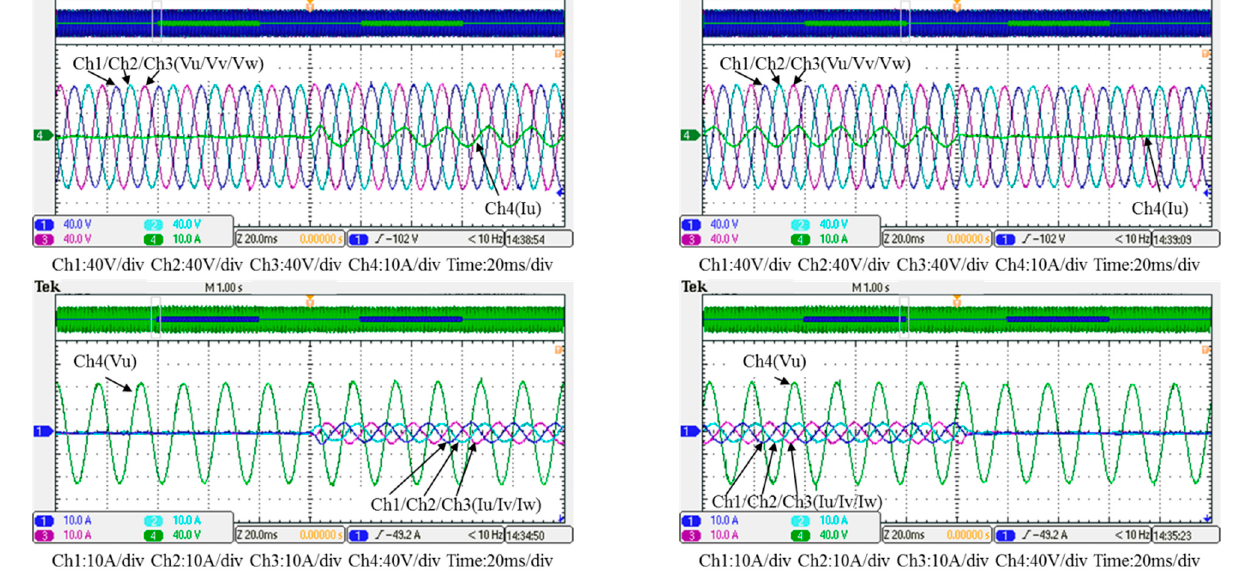
Figure 31. Detailed view of Figure 29: ( a ) near t 1 ; ( b ) near t 2 .